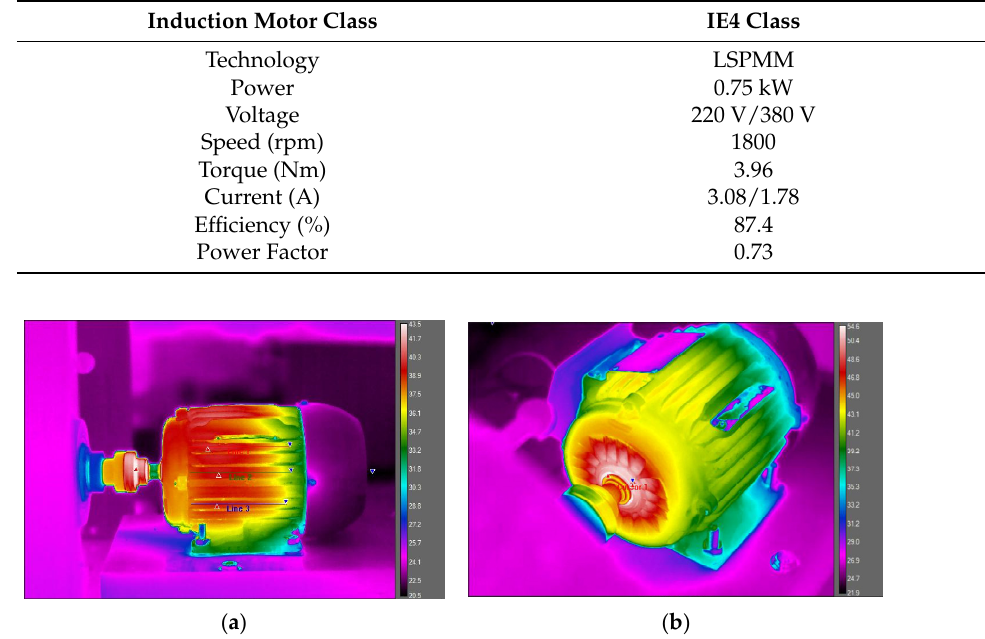
Figure 5. Thermographic images of the line-start permanent magnet motor in presence of voltage harmonics [8]: ( a ) lateral view; ( b ) front view.